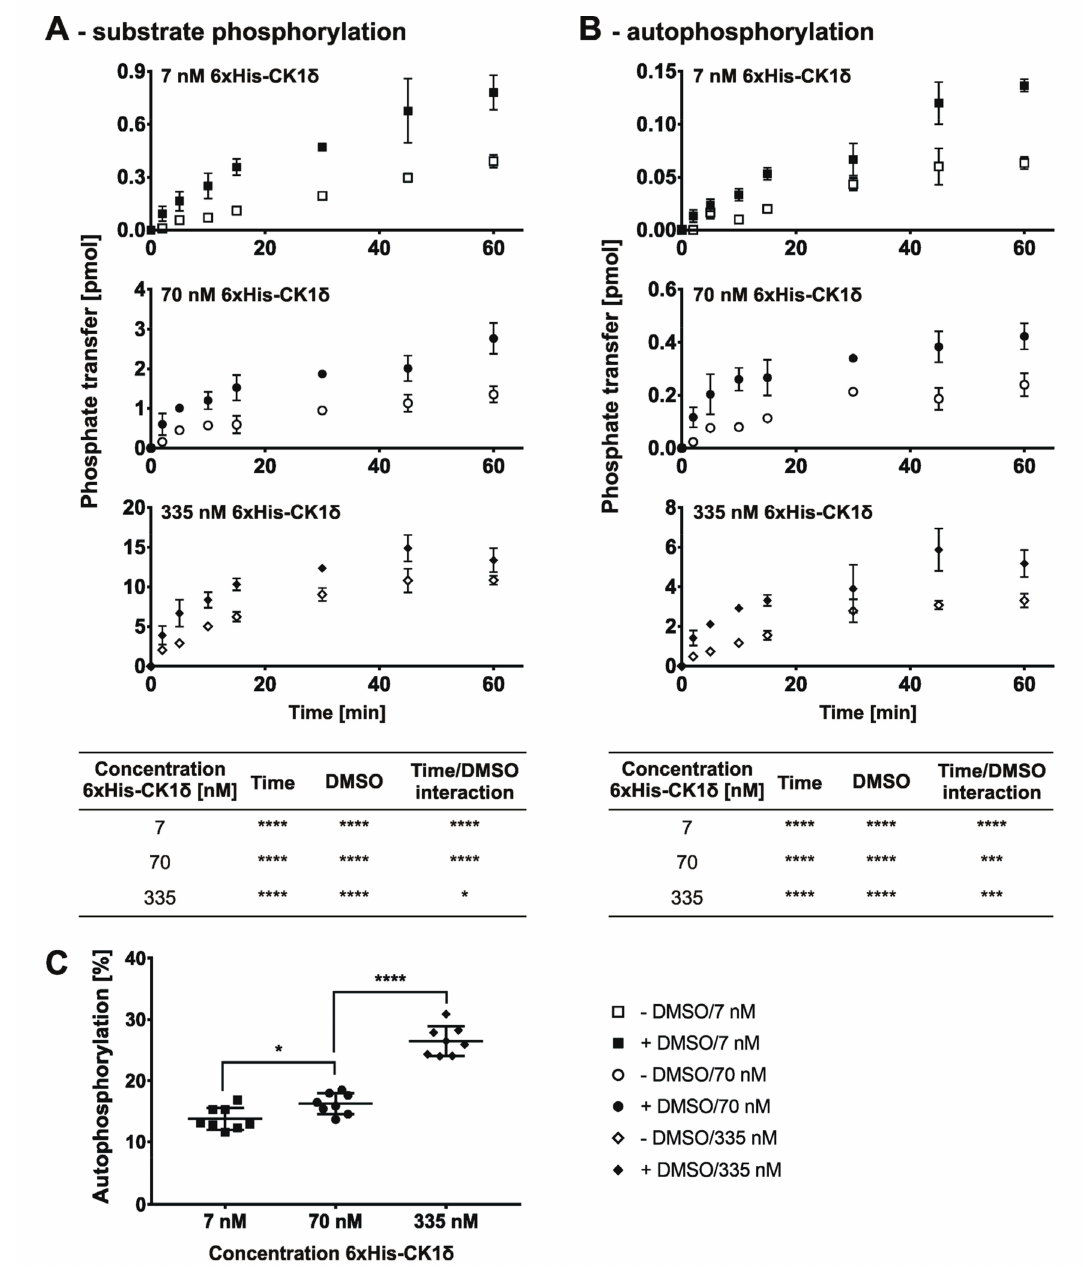
Figure 5. Product-over-time progression curve for 6 × His-tagged CK1 δ autophosphorylation and substrate phosphorylation. ( A ) Time-dependent phosphate transfer from [ γ - 32 P]-ATP to the substrate α -casein catalyzed by human recombinant 6 × His-tagged CK1 δ using different enzyme concentrations (7, 70, 335 nM) was determined by in vitro kinase reactions in absence and presence of solvent (+/ − DMSO). ( B ) Time-dependent autophosphorylation of 6 × His-CK1 δ has been determined and is presented similar to data shown in ( A ). ( C ) The mean proportional autophosphorylation relative on total phosphorylation (cumulated time-points) is significantly increased at higher enzyme concentrations. Statistical significance was tested using two-way ANOVA (for data presented in ( A , B )) and unpaired two-tailed t -test ( C ). * indicates p ≤ 0.05, *** indicates p ≤ 0.001, **** indicates p ≤ 0.0001. DMSO, dimethyl